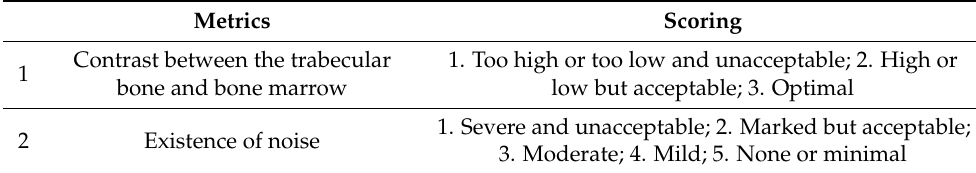
Table 1. Scoring method for the subjective